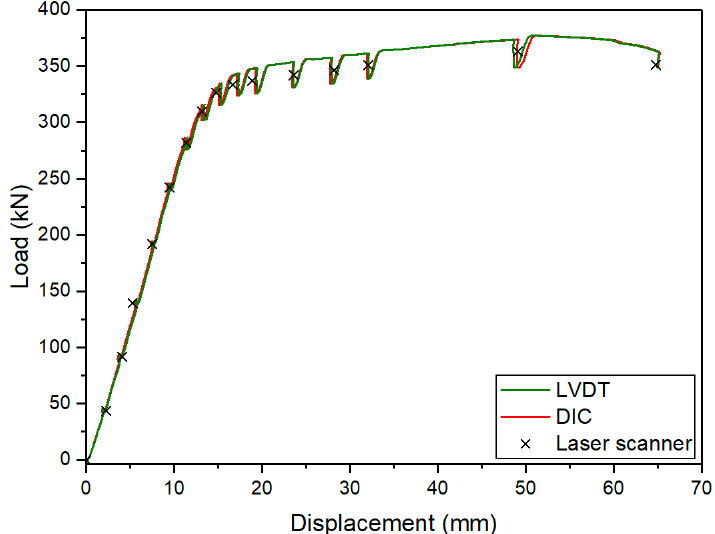
Figure 9. Static equilibrium path of the tested beam in the plastic range of displacements.